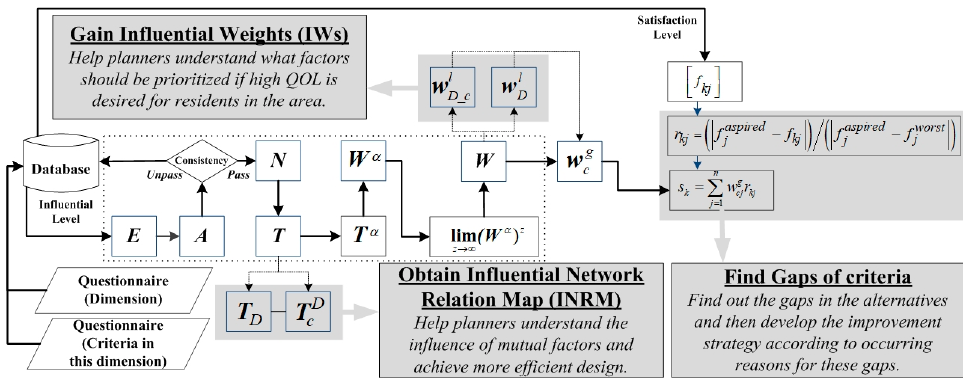
Table 5. The Average-direct influence relation matrix and total influence relation matrix of criteria in D 4 .